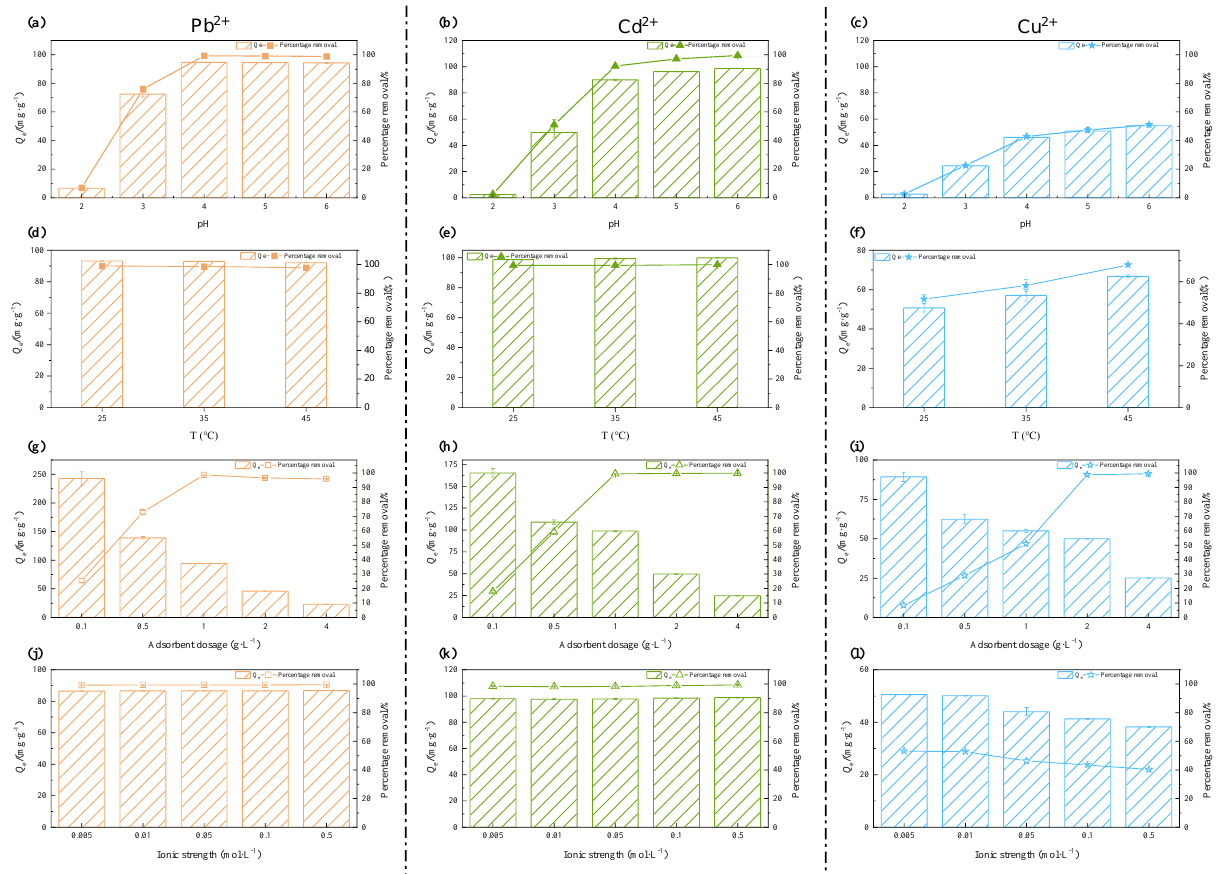
The impacts of pH, temperature, adsorbent addition dose and ionic strength on metal removal efficiency and adsorption capacity were determined (Figure 3). removal efficiency and adsorption capacity were determined (Figure 3).